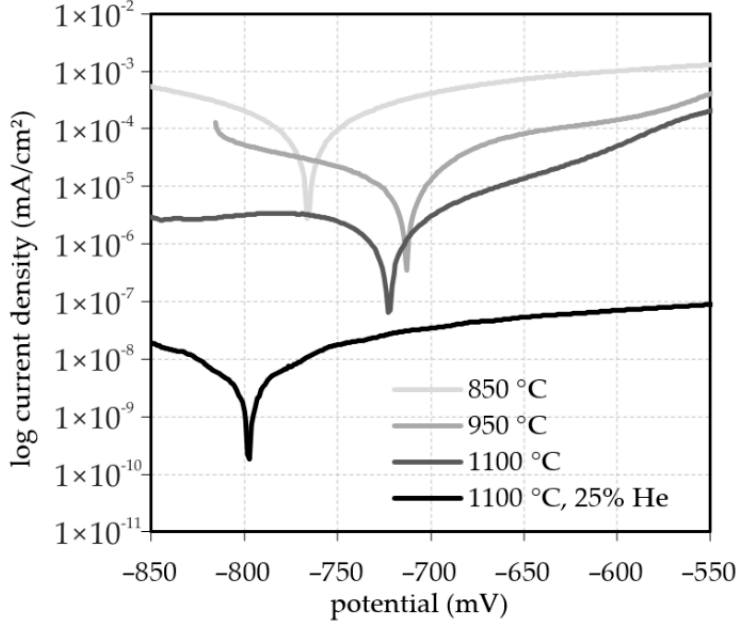
Figure 6. Polarization curves of CGS-sprayed AISI 316L coatings in dependence of the process pa- rameters.